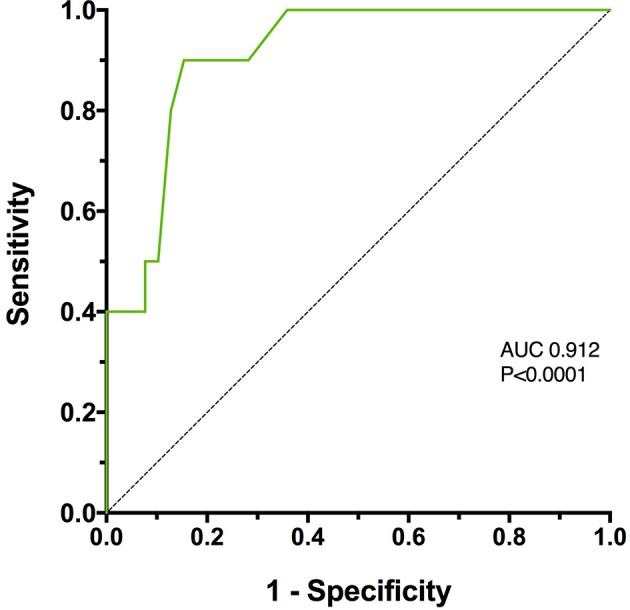
A receiver operating characteristic (ROC) curve of Acute Patient Physiology and Laboratory Evaluation (APPLE) score assessing its association with survival in 49 dogs following moderate-severe trauma. The area under the curve (AUC) was 0.912, which was significantly greater than 0.5 (P < 0.0001).